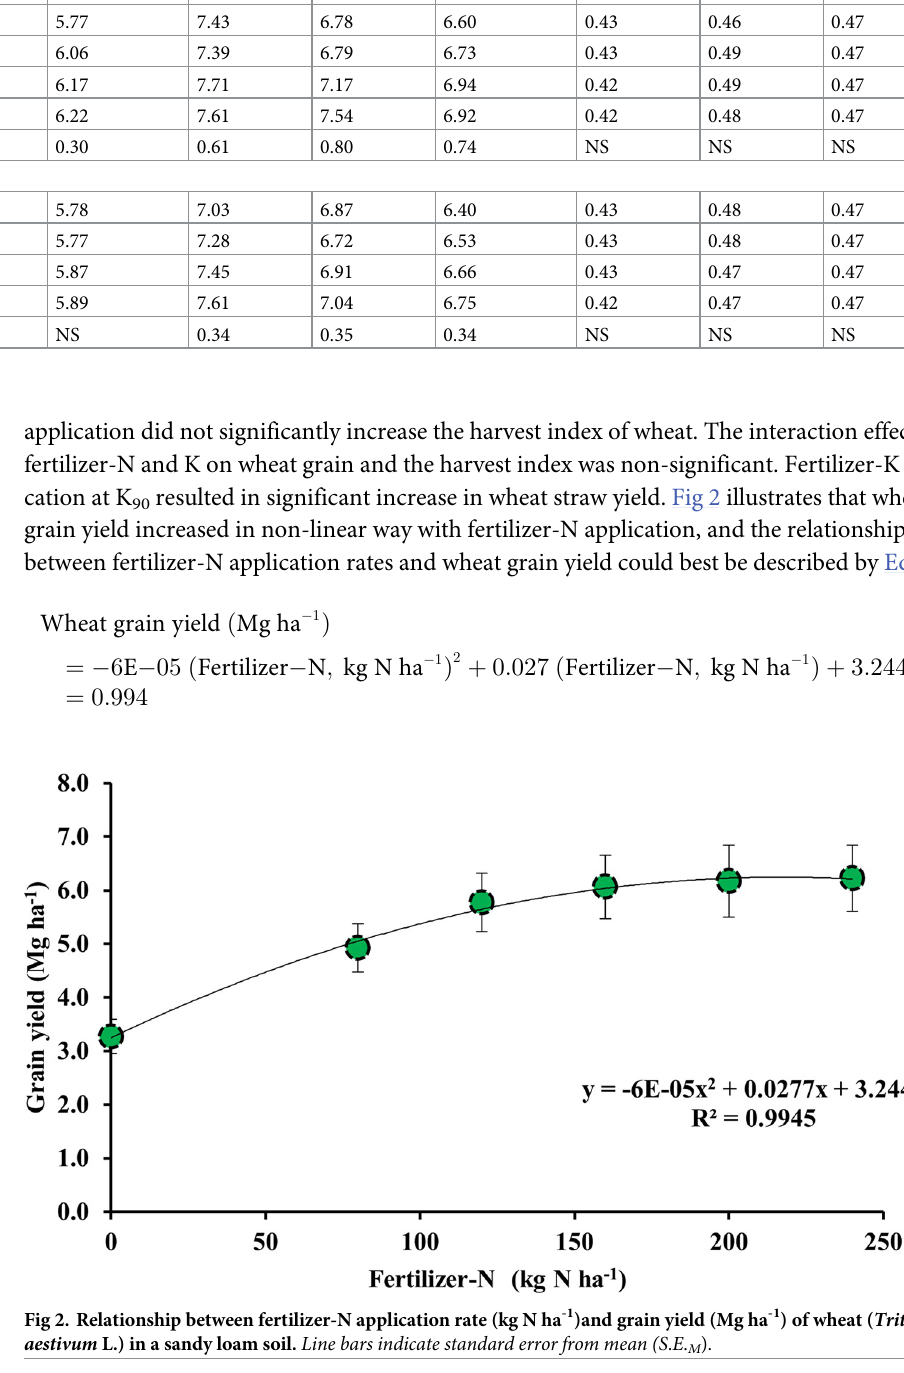
Fig 2. Relationship between fertilizer-N application rate (kg N ha -1 )and grain yield (Mg ha -1 ) of wheat ( Triticum aestivum L.) in a sandy loam soil. Line bars indicate standard error from mean (S . E . M ).